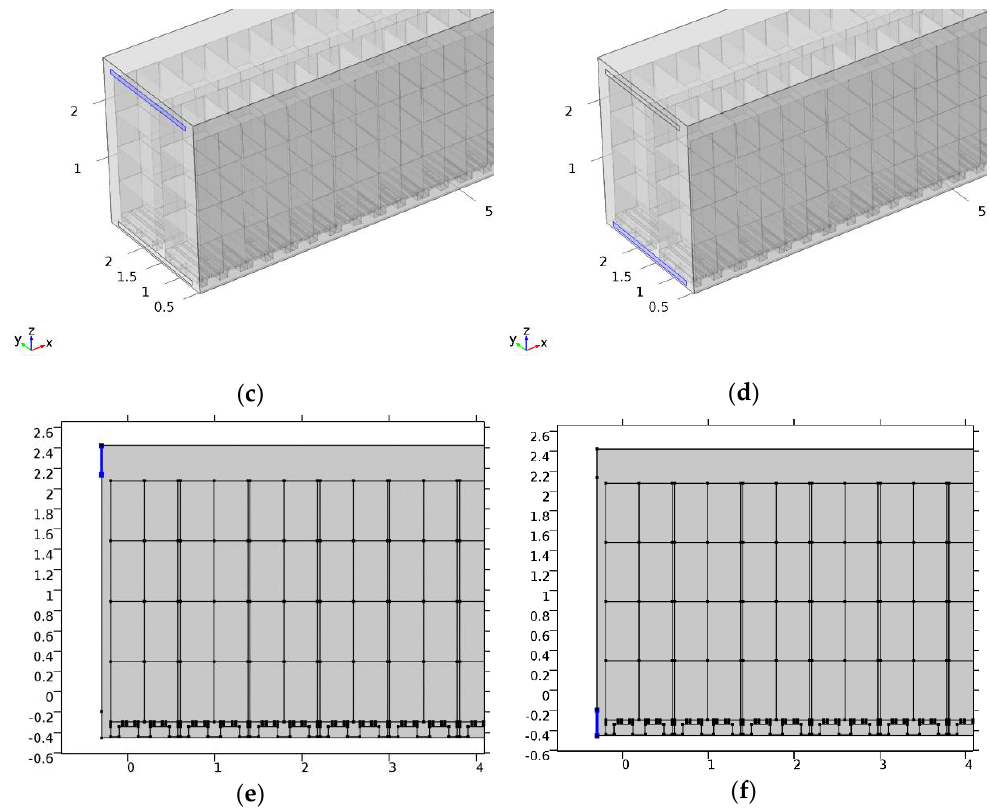
Figure 1. ( a ) A general view of the refrigerated semitrailer, ( b ) fully loaded with the palletized cargo, ( c ) the location of the inlet, ( d ) the location of the outlet, ( e ) the highlighted inlet (on the upper left corner) of the cross-section (2D) of the palletized cargo, ( f ) the highlighted outlet (on the bottom left corner) of the cross-section (2D) of the palletized cargo.